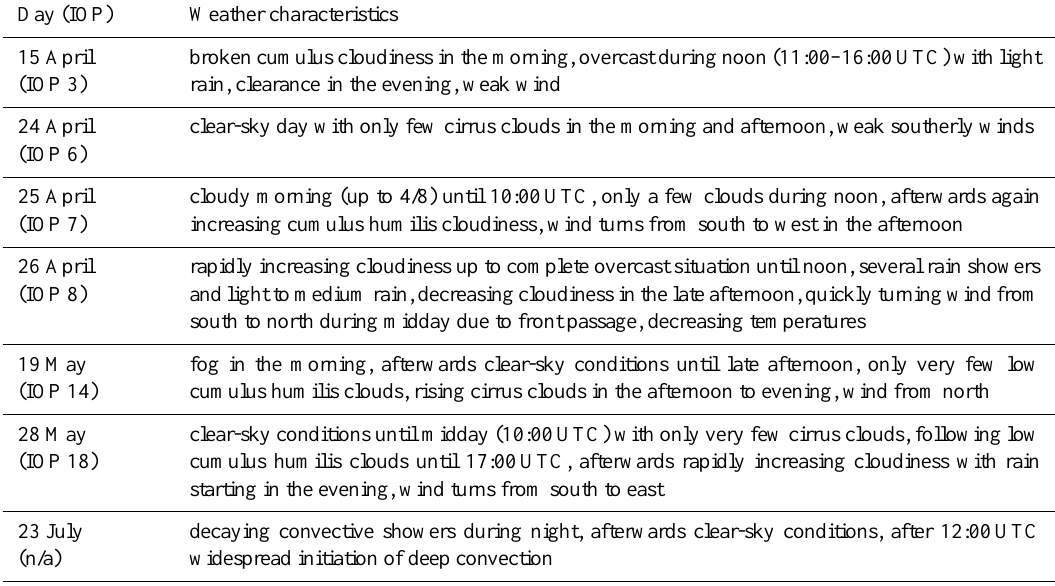
Table 2. Weather characteristics at the HOPE measurement site for the intensive observation periods (IOP) used in this study. “n/a” means not